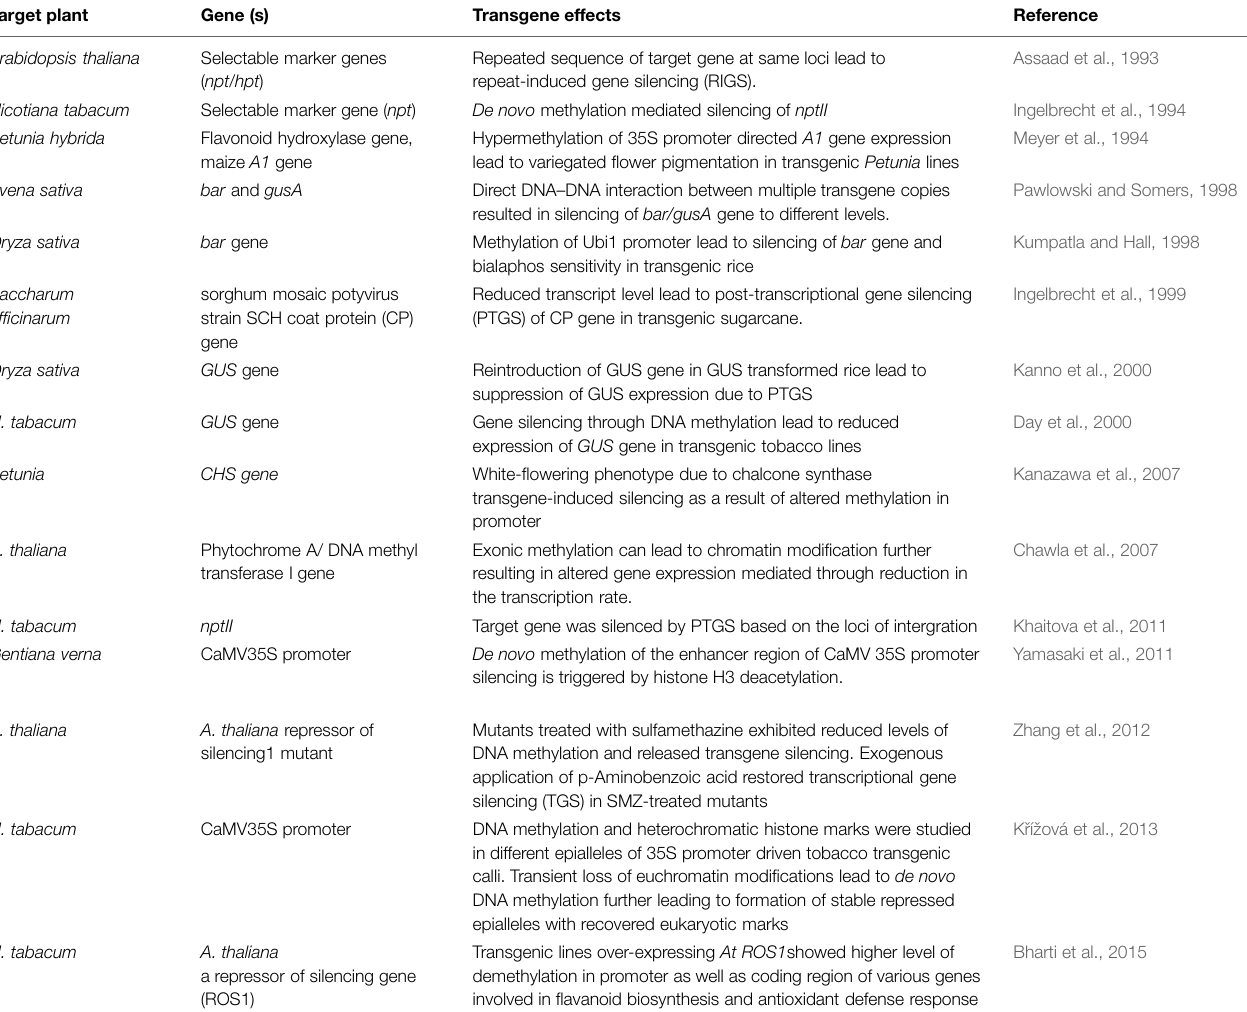
TABLE 1 | Reports of epigenetic silencing in transgenic